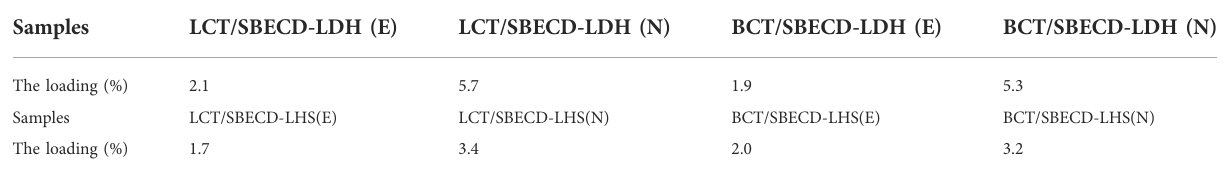
TABLE 1 Pesticide loading of the samples.